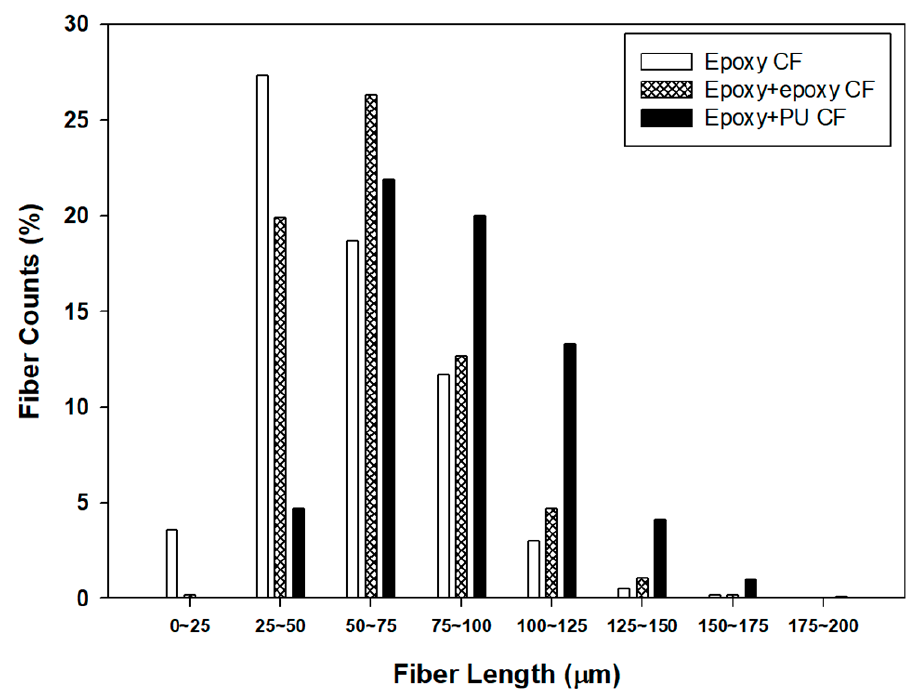
Figure 4. Fiber length distribution histogram for carbon fiber/ABS composites with (epoxy) single- sized and (epoxy + epoxy, epoxy + PU) dual-sized carbon fibers.